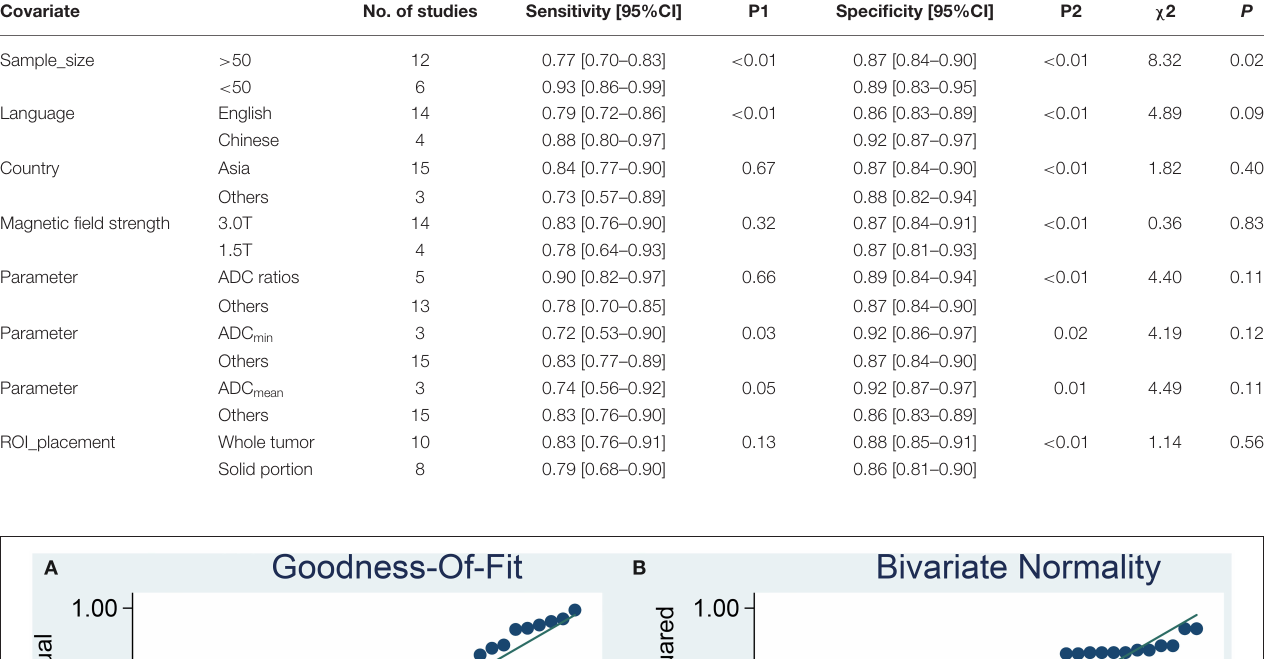
TABLE 3 | Results of subgroup analysis and meta-regression analysis.